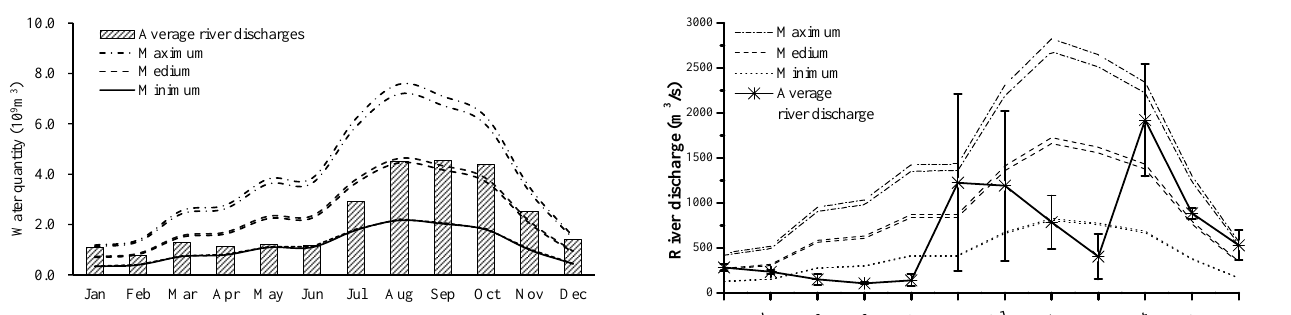
Fig. 3. Environmental flow for critical habitats in different seasons (spring and autumn) for (a) Habitat a; and (b) Habitat b shown in Fig. 1.